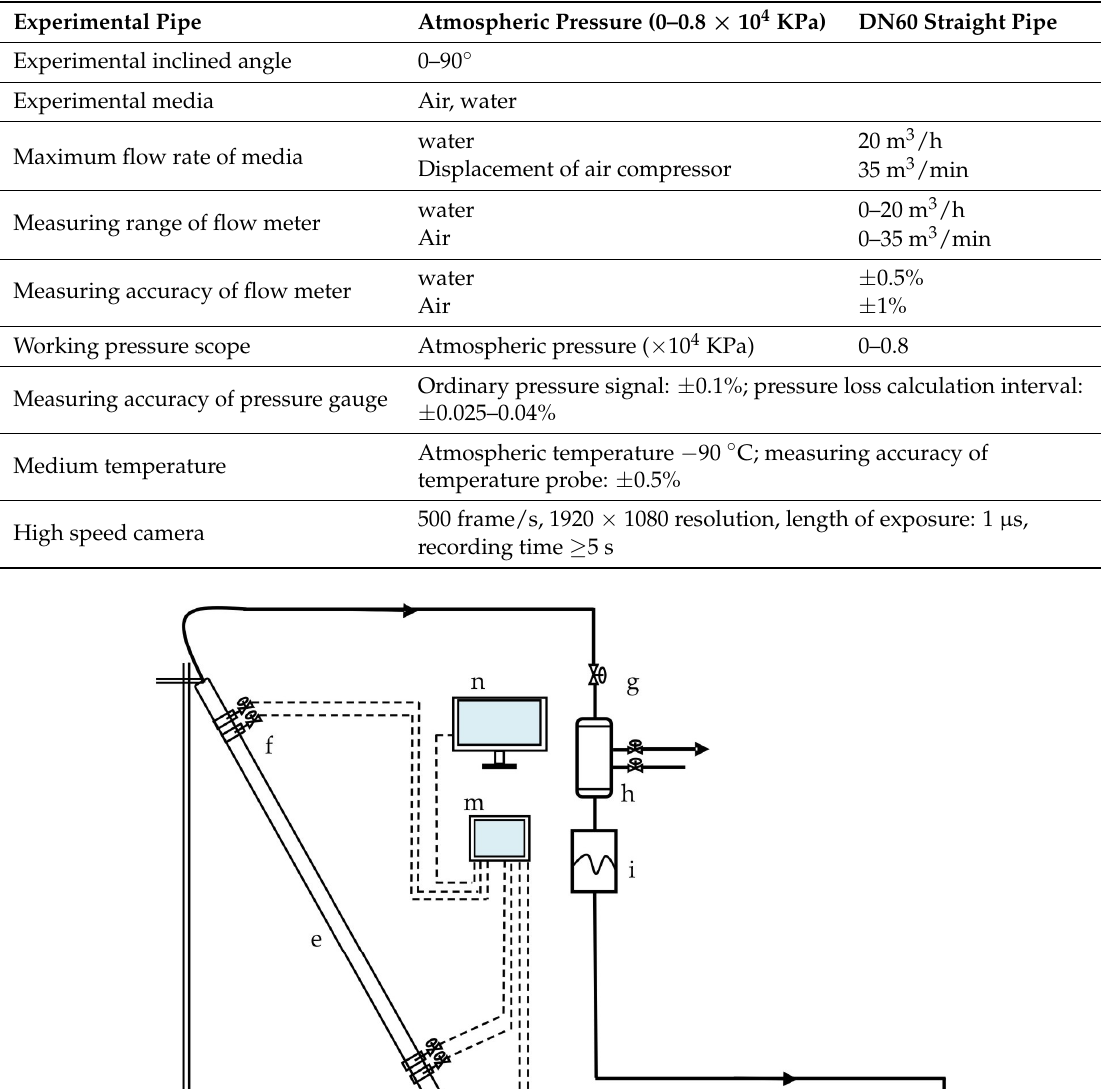
Table 1. Parameters of experimental apparatus.